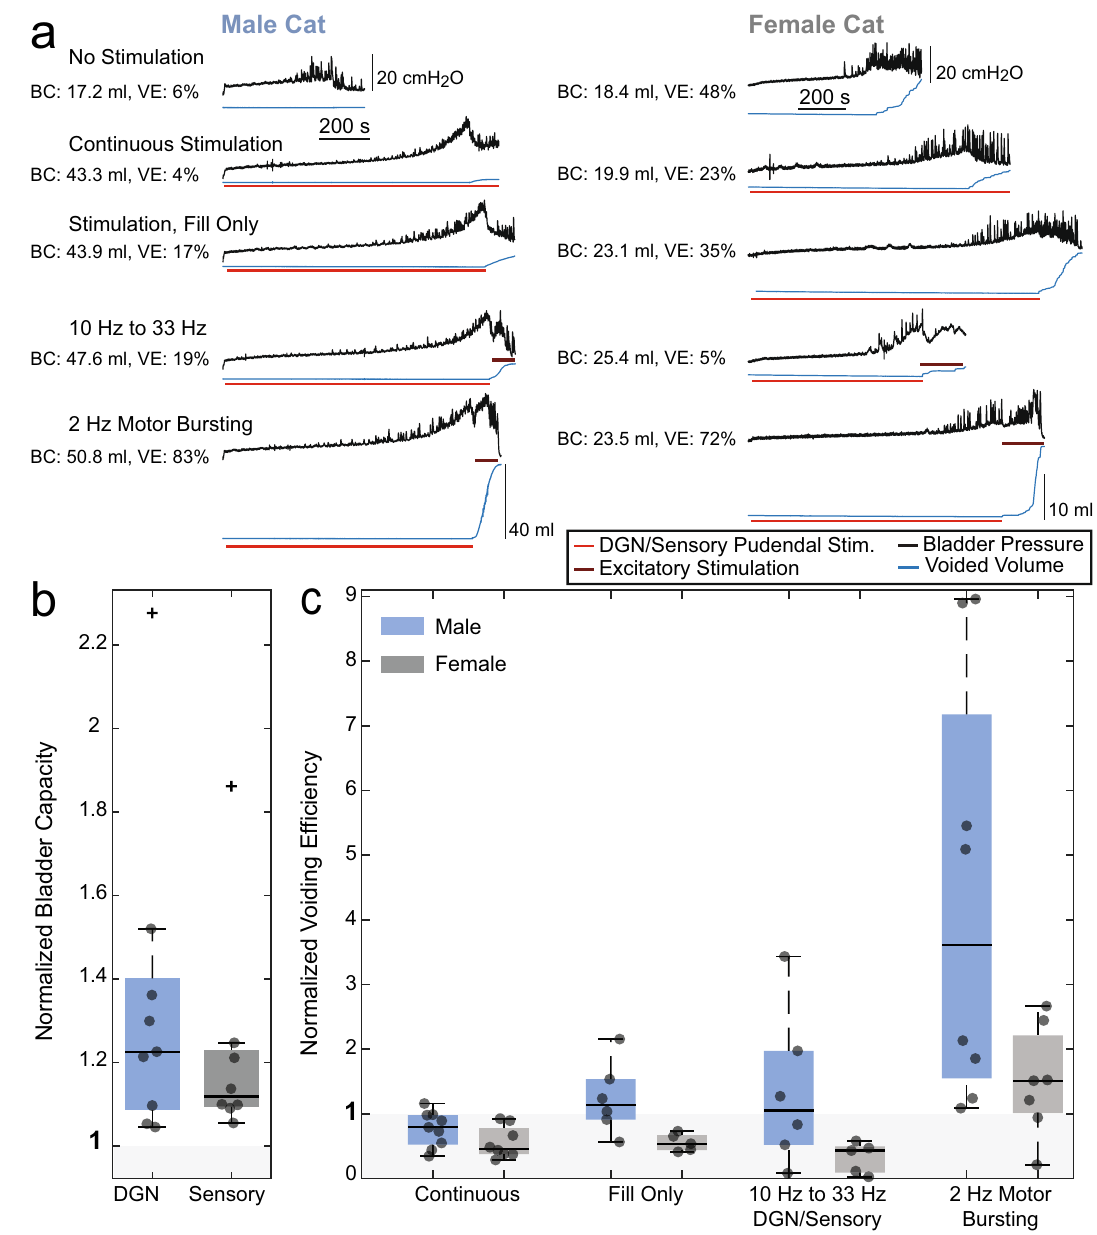
Figure 3. State-dependent stimulation restored both continence and efficient bladder emptying in male (n = 9) and female (n = 8) cats. ( a ) Cystometrograms from single trials with bladder pressure (black) and voided volume (blue) shown. Red lines indicate the duration of sensory pudendal stimulation (10 Hz, 1 T) to inhibit the bladder and promote storage. Brown lines above the voided volume traces indicate the duration of 33 Hz sensory stimulation or motor bursting stimulation to activate the bladder and promote emptying. Average BC and VE for each type of trial for the example experiments are listed next to the traces. ( b ) Normalized BC for all experiments relative to controls. All relevant trials within an experiment were averaged together resulting in a single data point for each experiment. Average normalized BCs were 130% (males, P = 0.011, n = 9) and 120% (females, P = 0.027, n = 8). ( c ) Normalized VE for all stimulation conditions relative to controls (males: P = 0.013; females: P = 0.022). Continuous stimulation decreased VE relative to controls (males: 71%, P = 0.028, n = 9; females: 51%, P = 0.013, n = 8). State-dependent stimulation with motor bursting increased not only BC but also VE in males (452%, P = 0.004, n = 8) but not females (235%, P = 0.069, n = 7) relative to continuous stimulation. In females, removal of one explainable outlier (Fig. 4) yielded an increase in VE relative to continuous stimulation (307%, P = 0.007, n = 6) and controls (161%, P = 0.032, n = 6). Paired t tests were